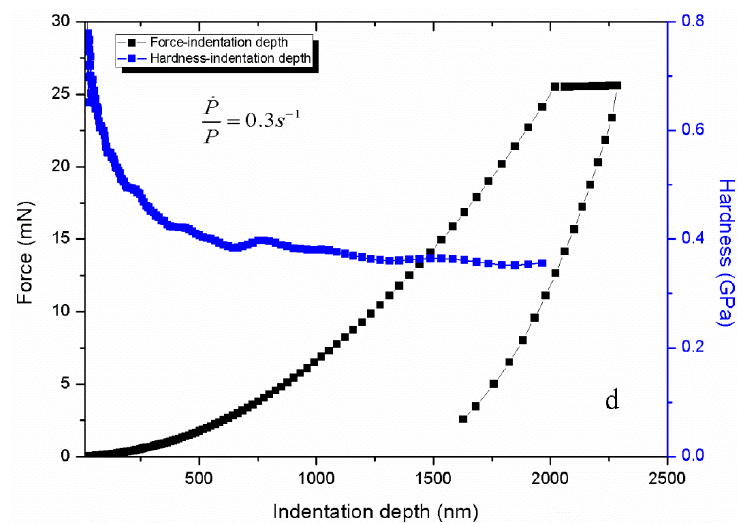
Figure 4. Typical nanoindentation force–depth curves and relation of hardness and indentation depth under different P .